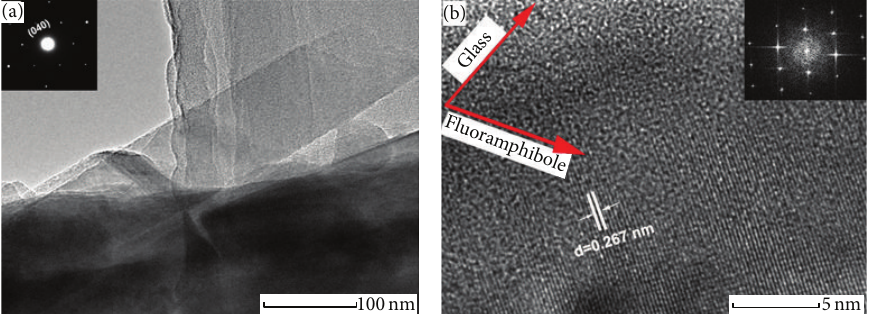
Figure 7: TEM (a, inset is the selected area electron diffraction) and HRTEM (b, inset is the fast Fourier transform) photographs of glass in sandwich